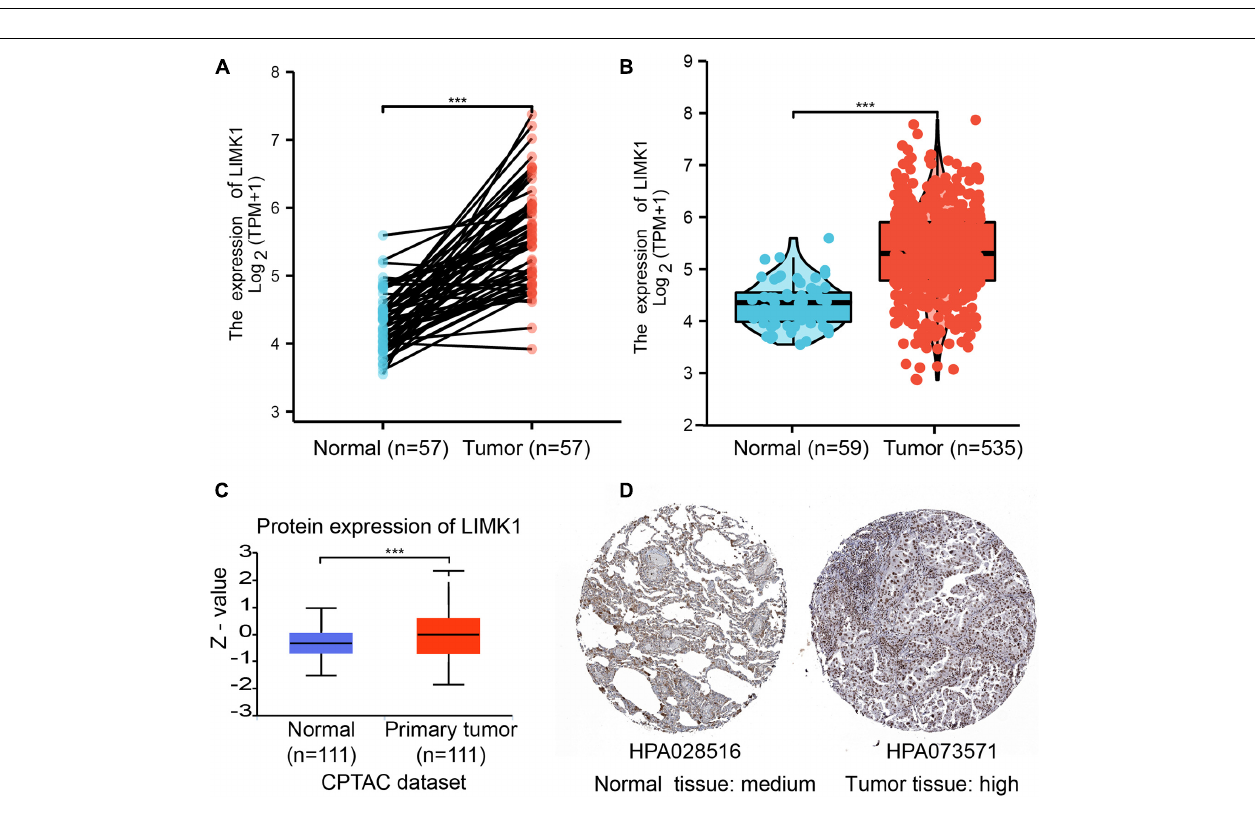
FIGURE 2 | The mRNA and protein expression of LIMK1 in lung adenocarcinoma. (A) The mRNA expression levels of LIMK1 in 57 lung adenocarcinoma and matched-adjacent normal samples. (B) The mRNA expression levels of LIMK1 in 535 lung adenocarcinoma samples and 59 normal samples. (C) The protein expression levels of LIMK1 based on CPTAC. (D) The protein levels of LIMK1 based on Human Protein Atlas. Normal tissue, https://www.proteinatlas.org/ ENSG00000106683-LIMK1/tissue/lung#img; Tumor tissue, https://www.proteinatlas.org/ENSG00000106683-LIMK1/pathology/lung+cancer#img (*** P < 0.001).